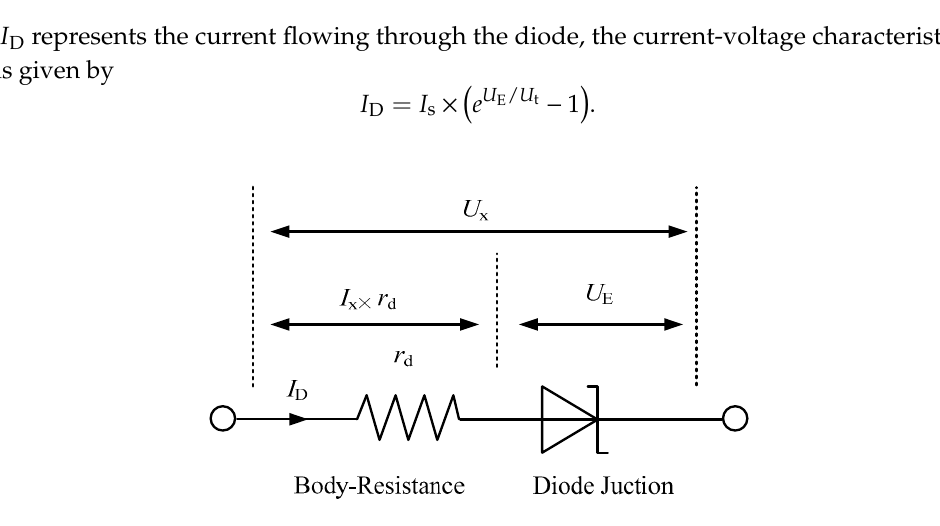
Figure 4. The equivalent model of diode under large current.